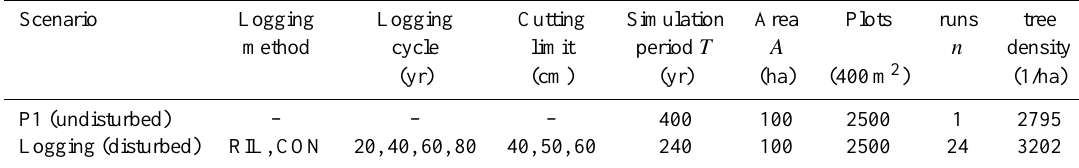
Table 1. Simulation scenarios. Undisturbed site P1 or different logging scenarios with disturbed